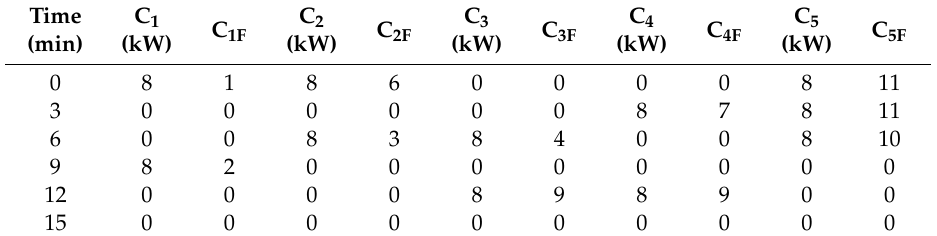
Table 5 indicates a possible management of the capacitors by adopting a single recharge threshold; the term Cif indicates that the capacitor is connected to the station f. Table 5. Management for a single recharge threshold, Power = 8 KW.